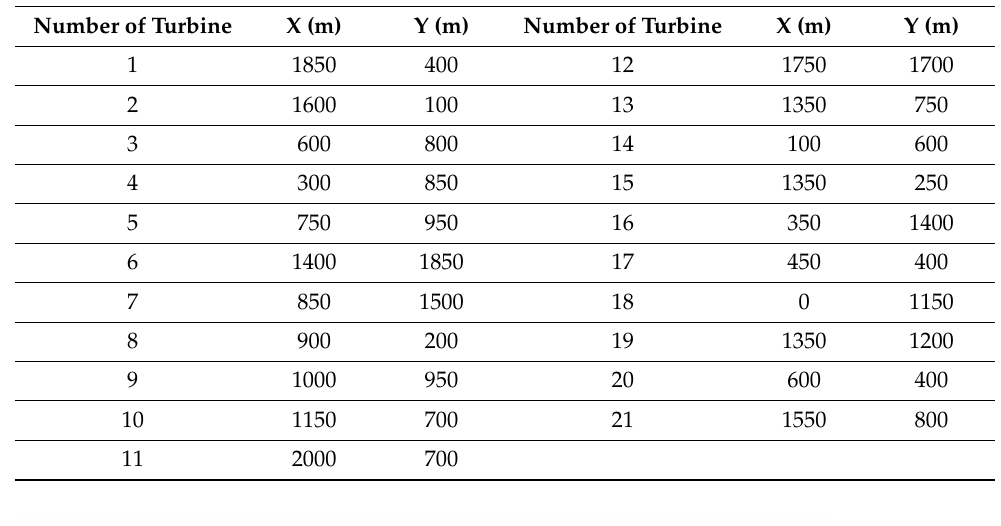
Table 9. Turbine coordinate in the 2-D case.